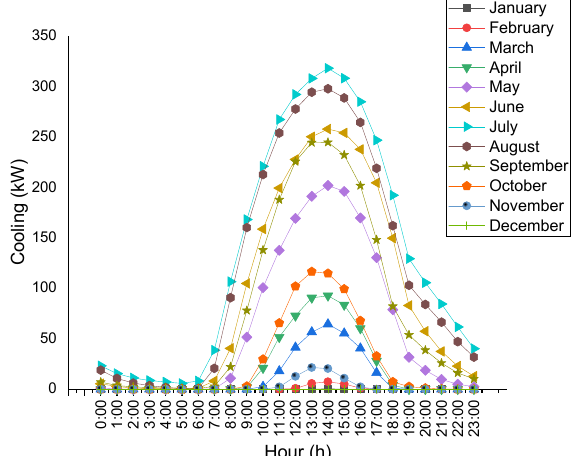
higher compared to the maximum electrical consumption in heating mode. Figure 14. The thermal power of the GHP operated in cooling mode for a year in Mexicali, Mexico.